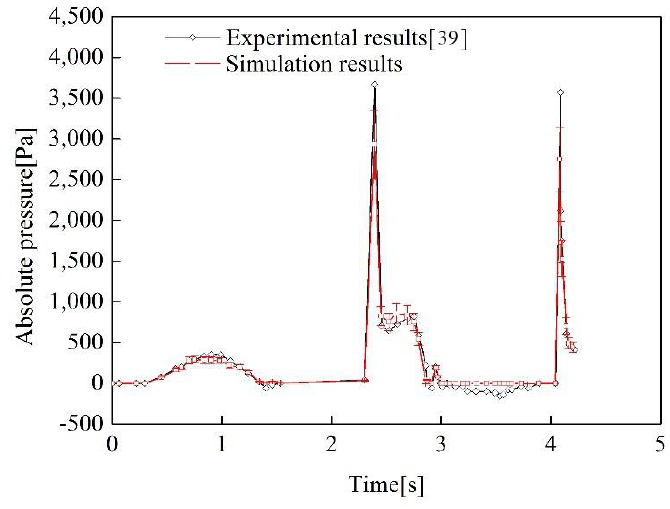
Figure 6. Verification of the sloshing model without a phase change.